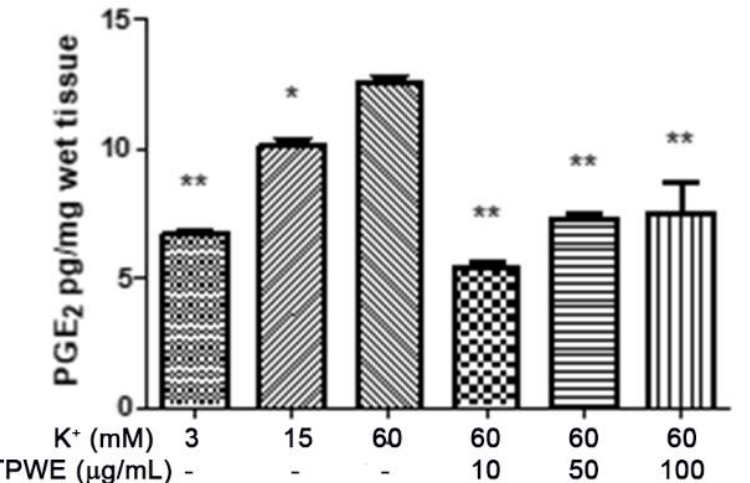
Figure 3. The inhibitory effect induced by Tanacetum parthenium water extract (TPWE: 10–100 µg/mL) on prostaglandin E 2 (PGE 2 ) level (pg/mg wet tissue) in isolated cortexes challenged with K + 60 mM. ANOVA, p < 0.01; * p < 0.05, ** p < 0.01 vs. the K + 60 mM group.